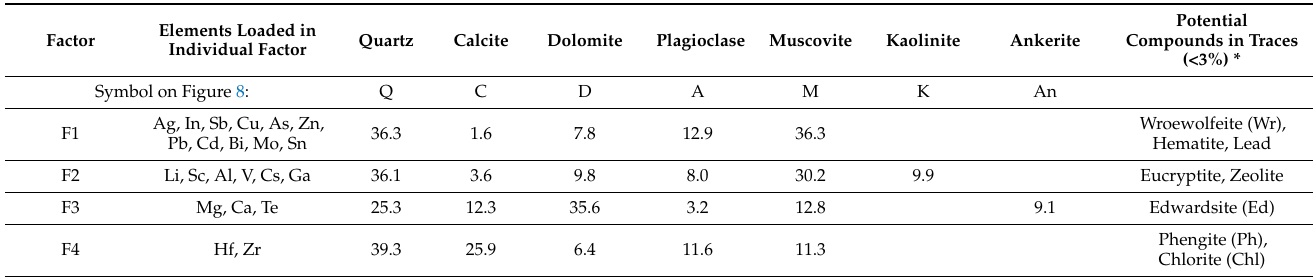
Table 3. The results of X-ray diffraction analysis for samples (<0.063 mm only) where the highest values of factor F1–F4 scores were